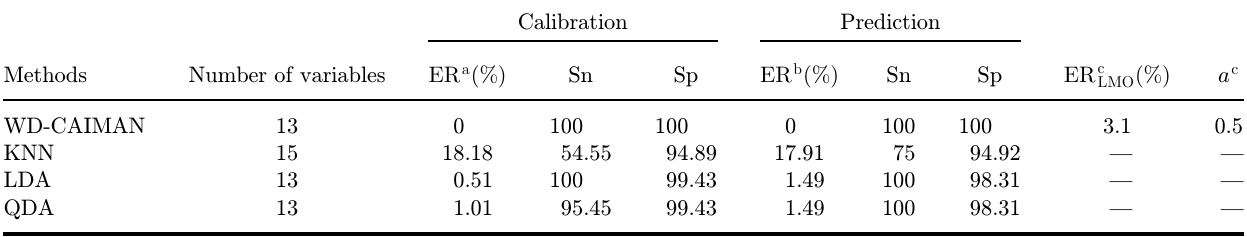
Table 3. Classi¯cation results obtained by WD-CAIMAN, KNN, LDA and QDA with retained wavelet coe±cients. Calibration Prediction